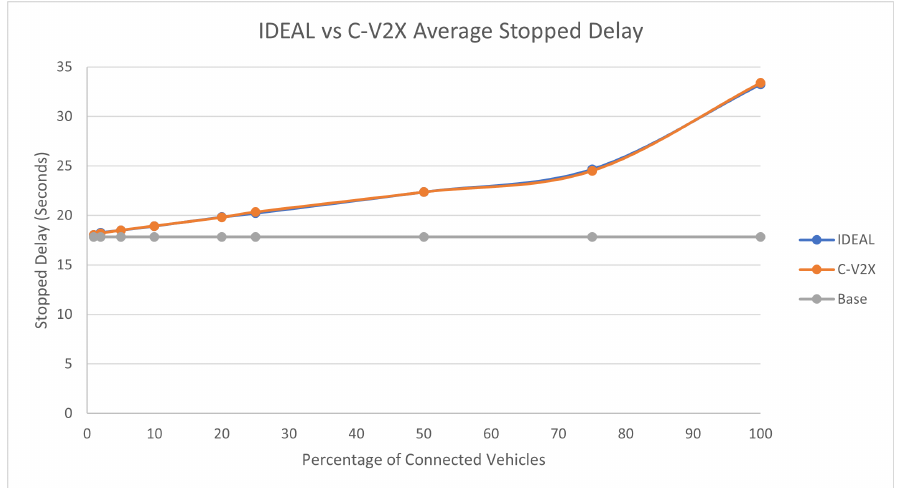
Figure 15. Average network-wide Stopped Delay of Energy-Efficient dynamic routing application using IDEAL and C-V2X communication on LA road network with traffic demand of scale factor